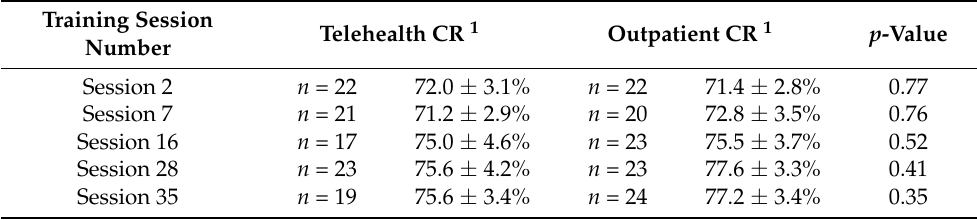
Table 2. Results of the training intensity in telehealth and outpatient